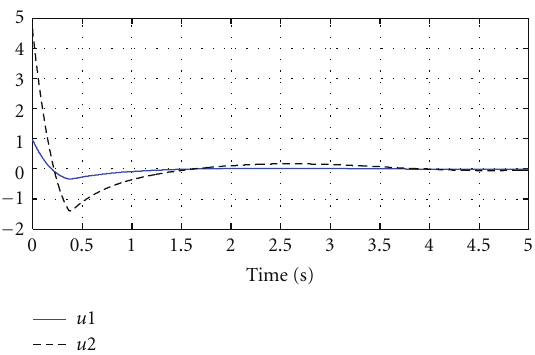
Figure 3: Control inputs with applying the sign function.